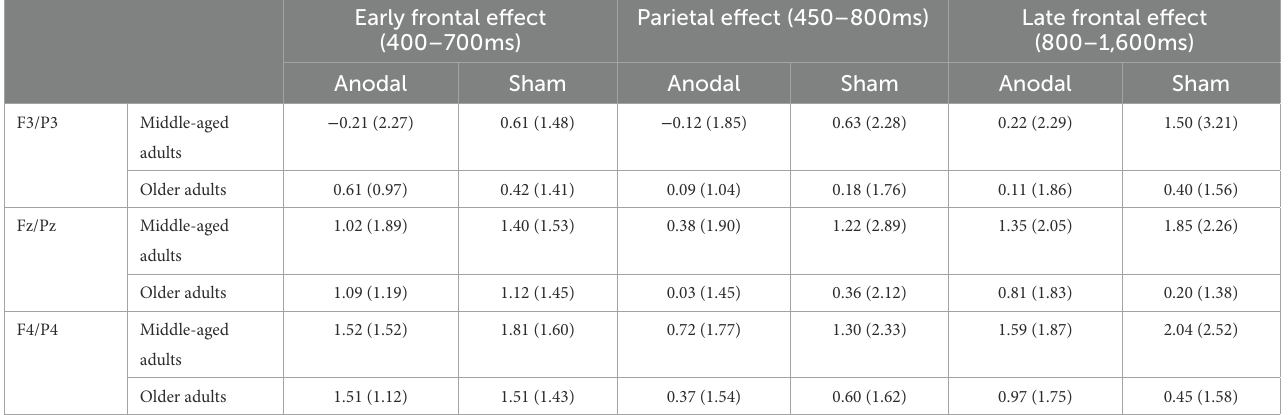
TABLE 2 Mean amplitudes and standard deviations (in parentheses) of the Early Frontal (EF), Parietal (P), and Late Frontal (LF) effects, measured in the Old-New difference waveforms, in the anodal and sham sessions, for the middle-aged adults and older adults at each electrode position where the effect was evaluated (F3, Fz, and F4 for the EF and LF effects, and P3, Pz, and P4 for the P